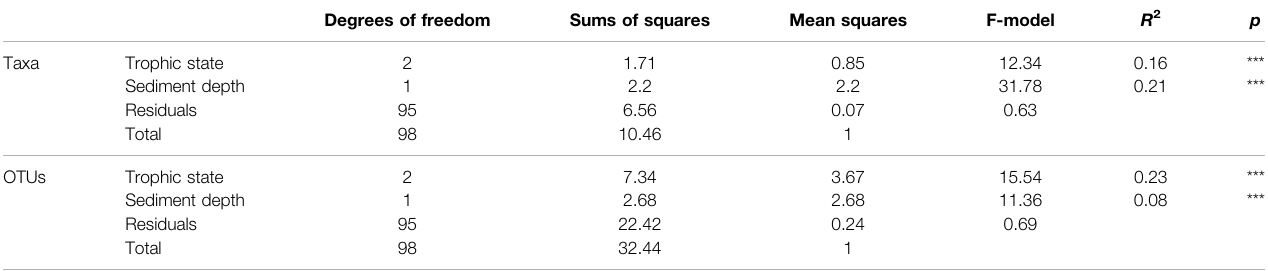
TABLE 4 | Permutational Multi-variate Analysis of Variance (PERMANOVA) results for differences in community composition in relation to trophic state at time of deposition and sediment depth (as a proxy for vertical respiration zone gradients). Taxa-level tests were used as a proxy for MOB community trends at the genus-level, while